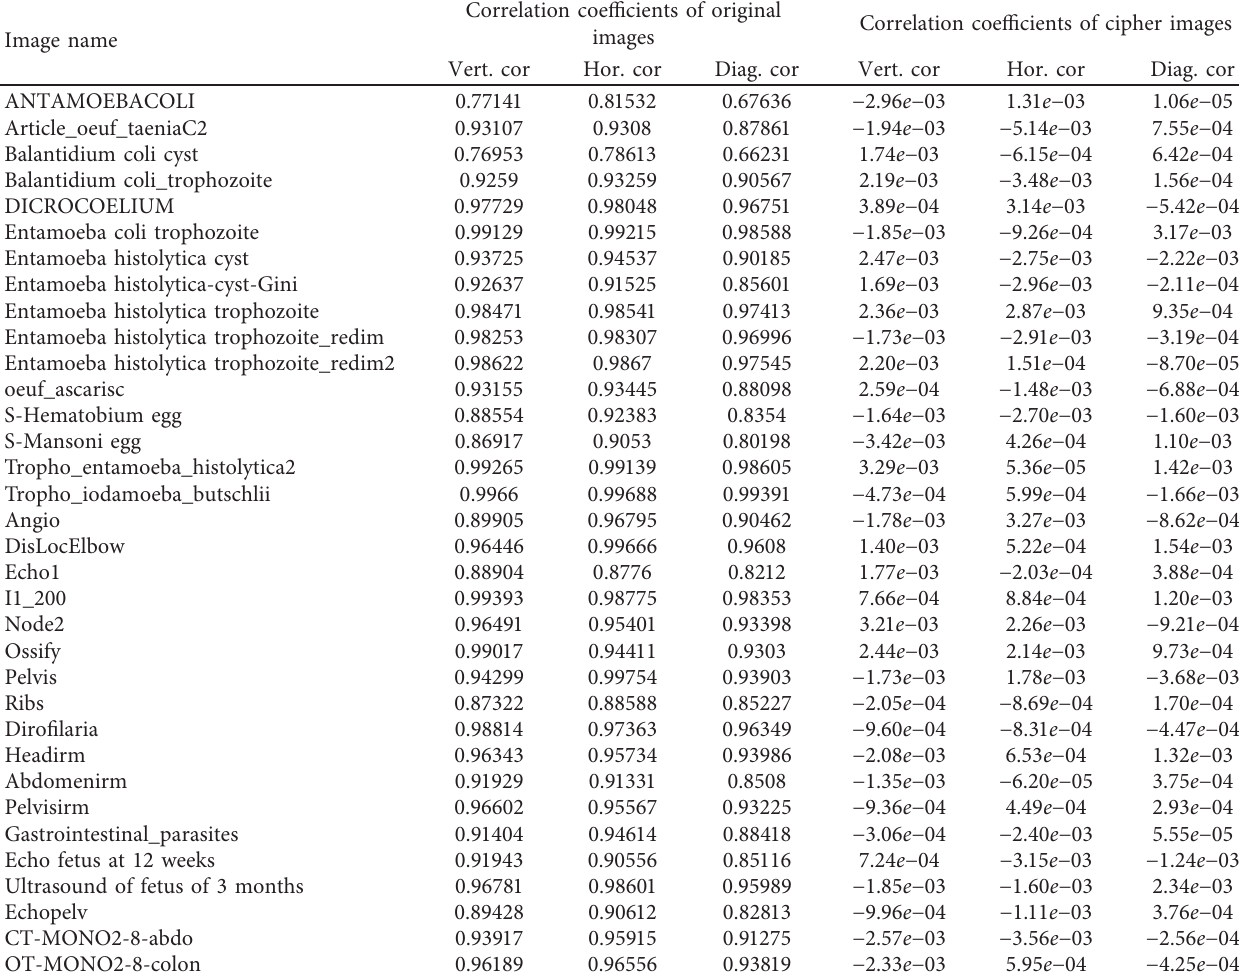
Table 5: Correlation coefficients between two vertically, horizontally, and diagonally adjacent pixels in several medical plain images and also in their corresponding encrypted images.